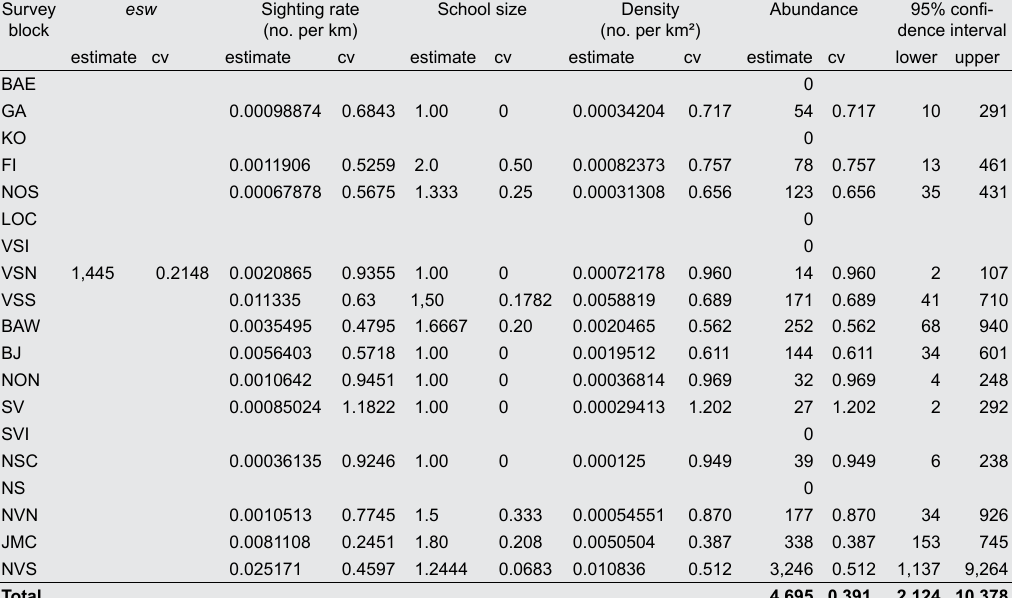
Table 9. Estimated abundance for humpback whales for the shipboard surveys 1996-2001, based on the combined data from platforms 1 and 2. Survey